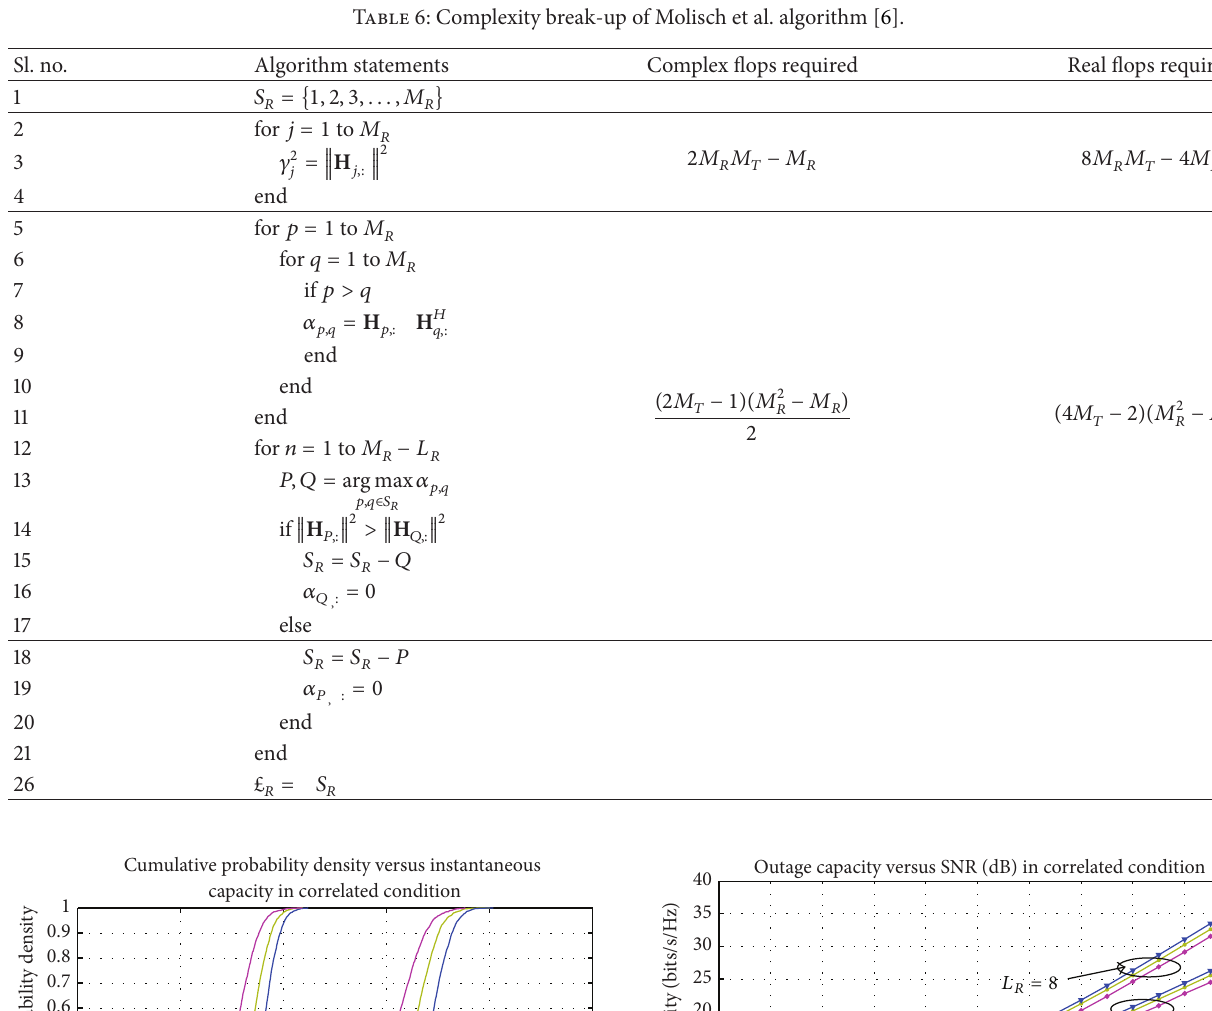
Table 6: Complexity break-up of Molisch et al. algorithm [6].